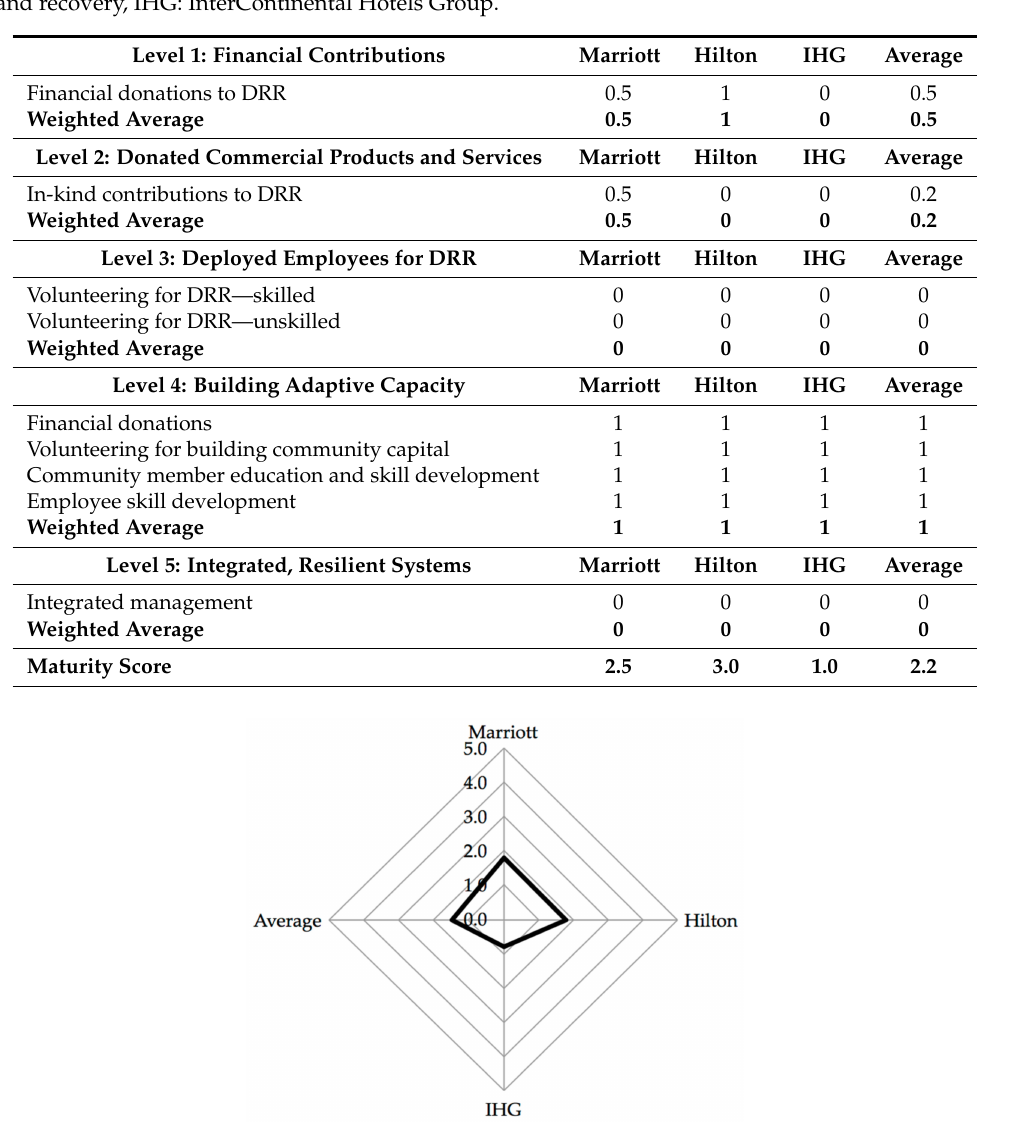
Figure 5. Maturity scores from vision/policy and goal analysis of the hotel and lodging